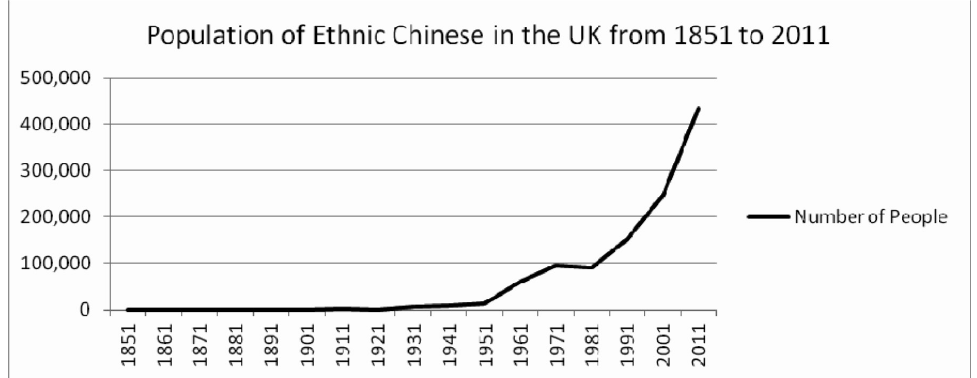
Figure 1: Population of Ethnic Chinese in the UK from 1851 to 2011. From various sources shown in Appendix 1. The graph shows the dramatic demographic shift following the realization of aspects of the opening up police in